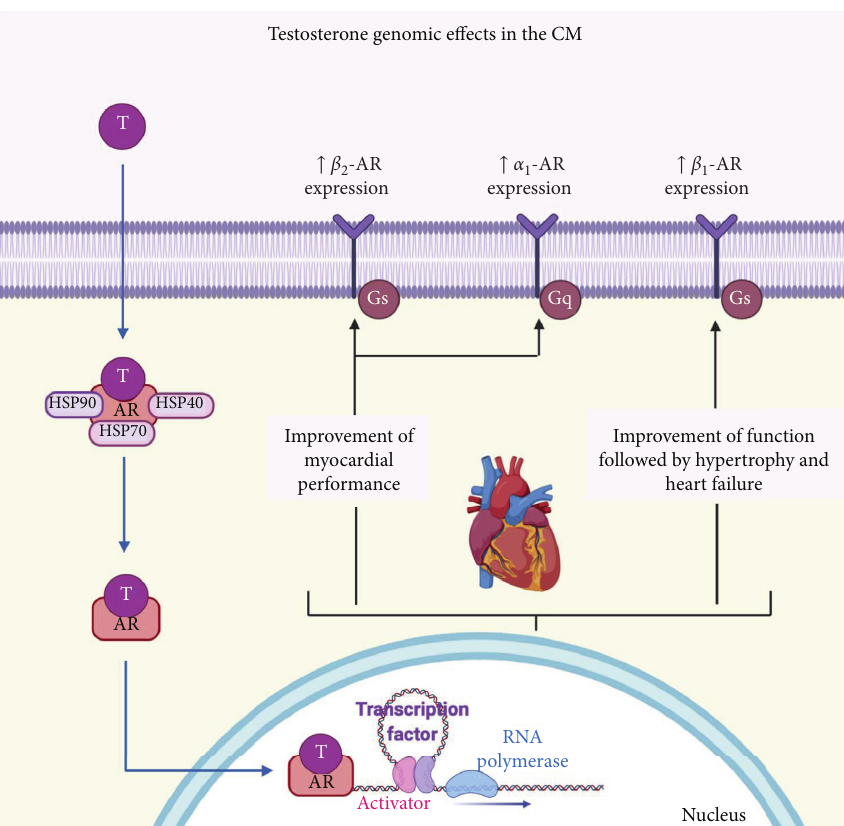
Figure 4: Genomic androgen effects on the adrenergic system in the cardiac muscle (CM). The genomic AR signaling involves androgen crossing the plasma membrane, entering the cytoplasm, dissociation of chaperone proteins, and binding to the AR. Testosterone (T) stimulates the expression of the α 1 -adrenergic receptor ( α 1 -AR) and β 2 -adrenergic receptor ( β 2 -AR), improving ionotropic activity and leading to the development of contraction without cardiotoxic effects. In addition, T increments the expression of the β 1 adrenergic receptor ( β 1-AR), acutely improving the cardiomyocytes' function, but chronically leading to hypertrophy and heart